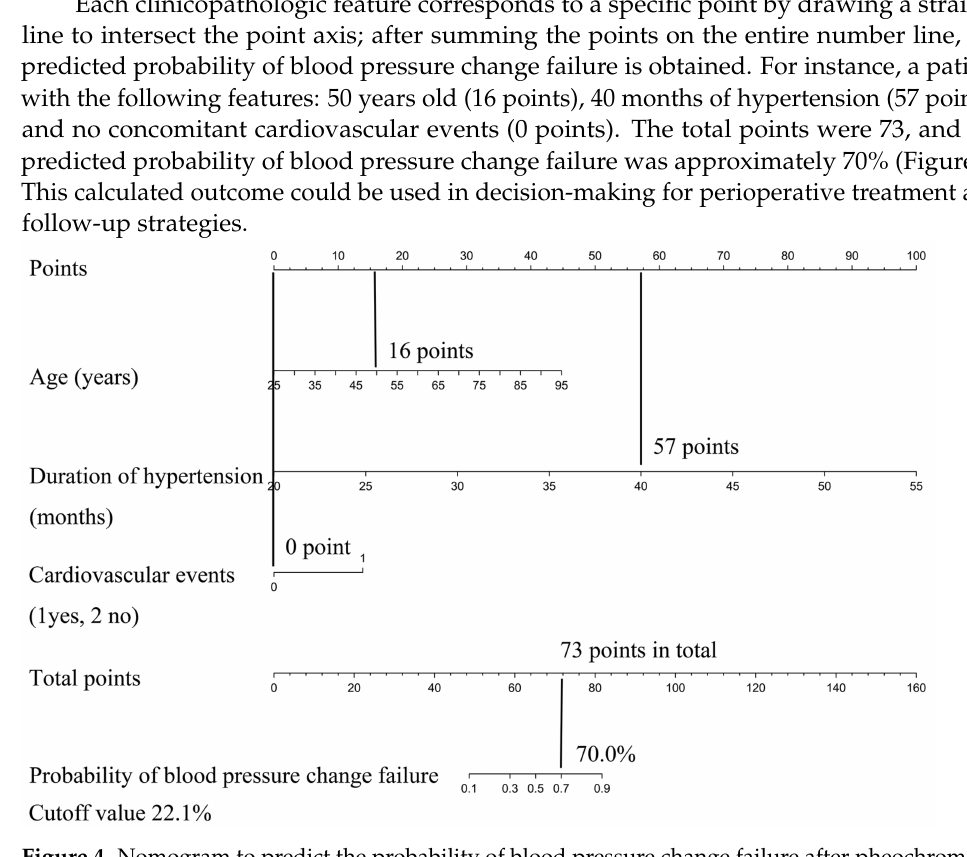
Figure 4. Nomogram to predict the probability of blood pressure change failure after pheochromocy- toma surgery for